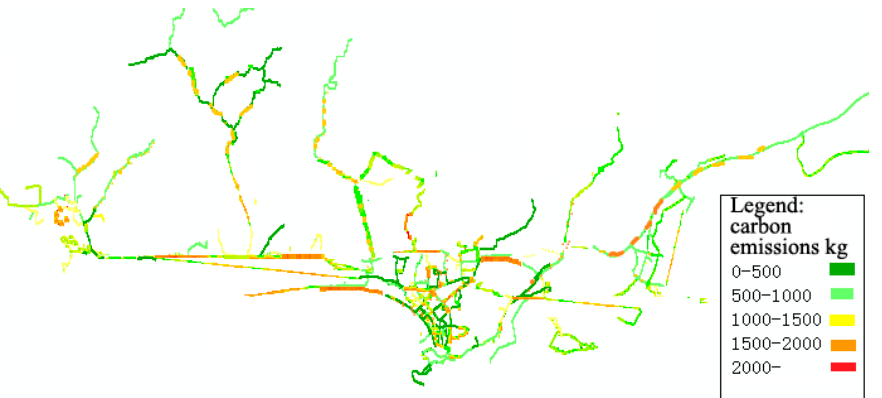
Figure 10. Spatial distribution of carbon emissions on buses lines in Sanya on weekdays.